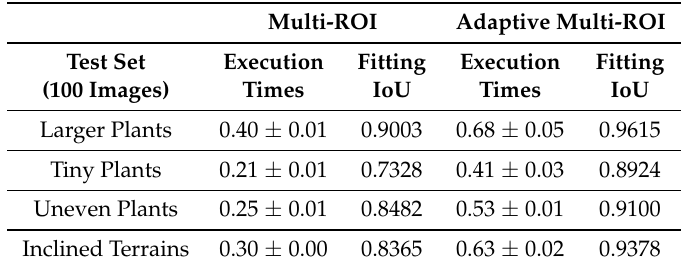
Table 1. Comparisons of fitting IoU between multi-ROI and proposed Adaptive multi-ROI